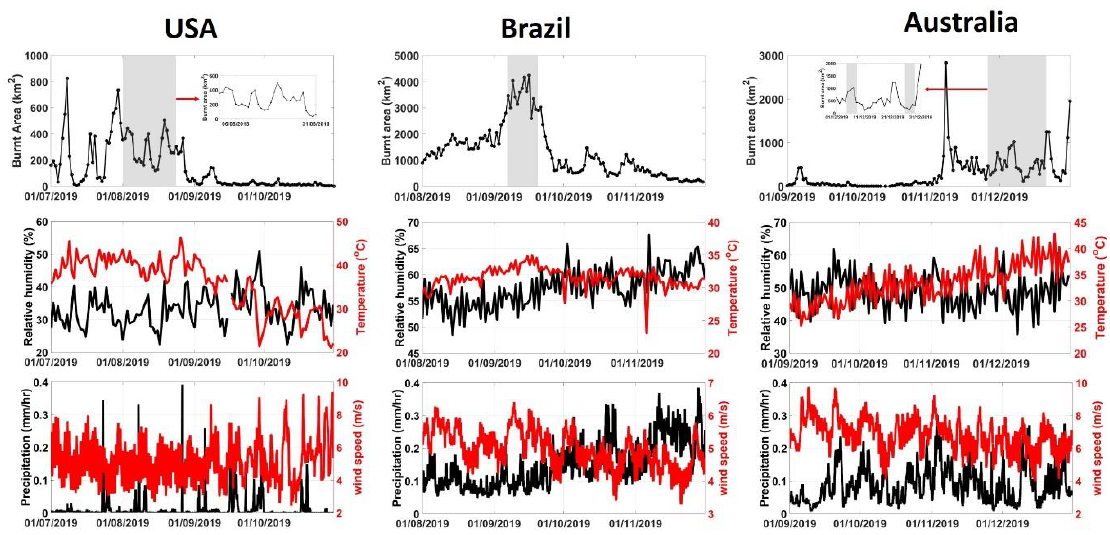
Figure 3. Changes, over time, in the daily Burned area (BA) and meteorological conditions (surface temperature (Ts), relative humidity (RH), precipitation (Prec.) and wind speed (Ws)) at various sites. The grey areas show periods when higher BA is observed.